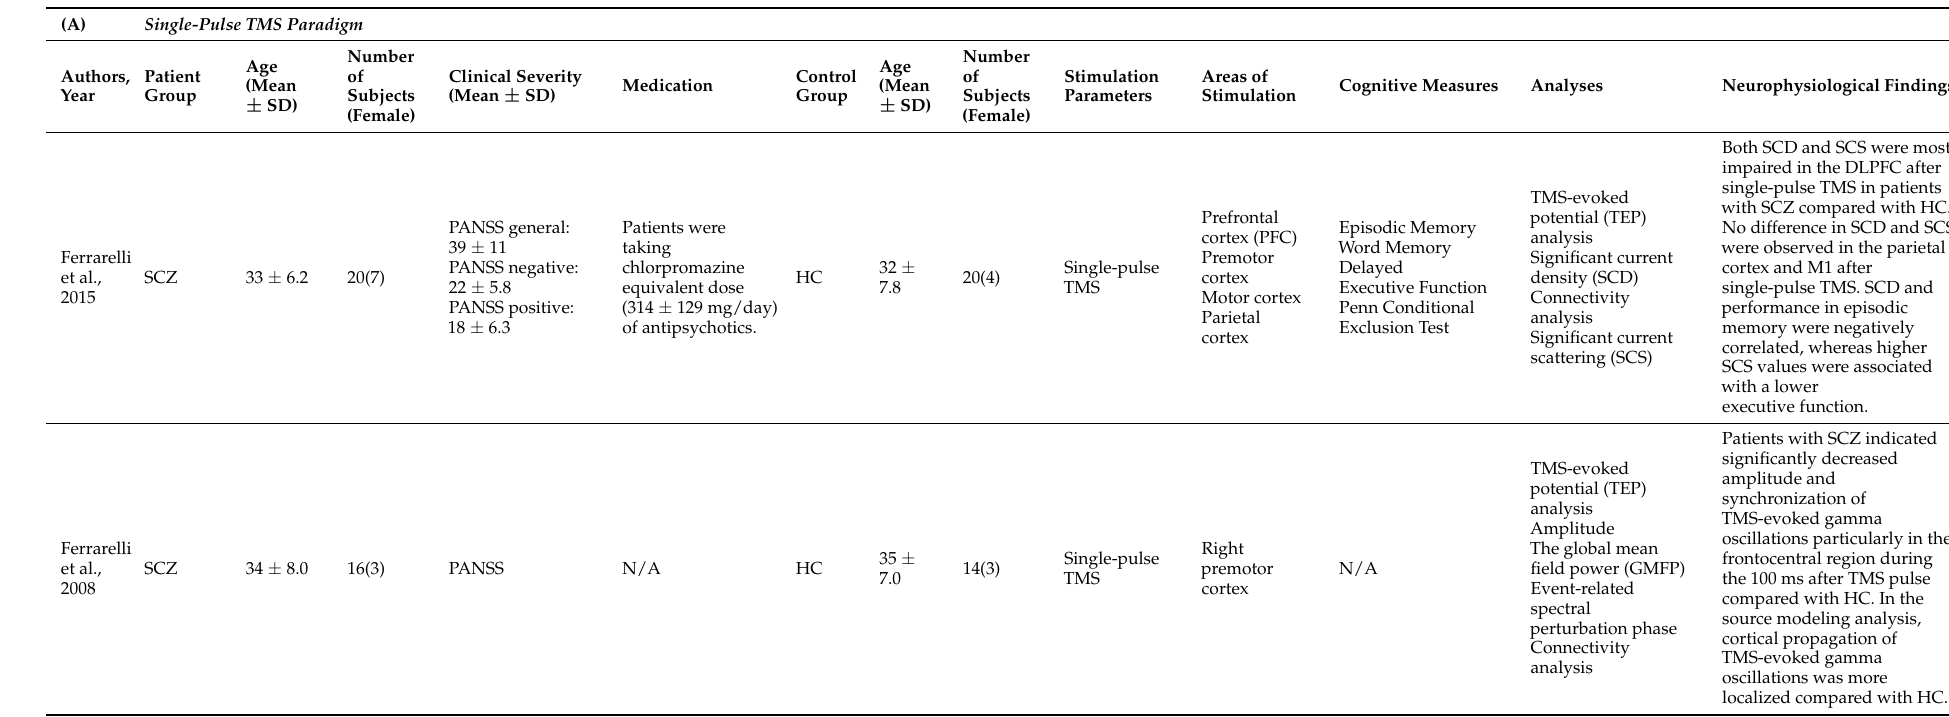
Table 3. Connectivity